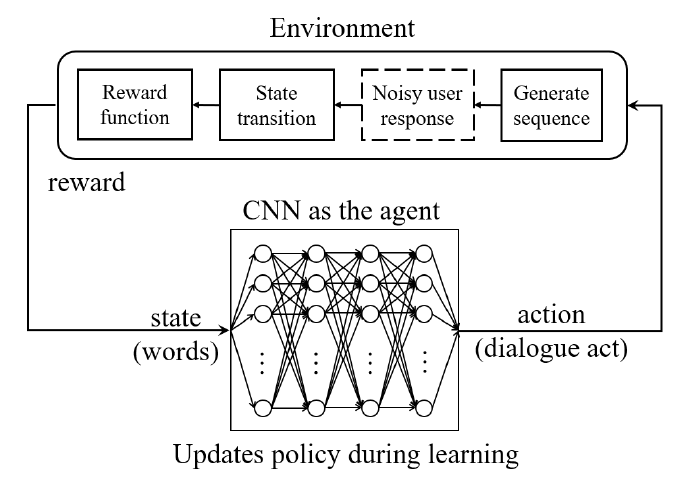
Figure 7. SimpleDS architecture